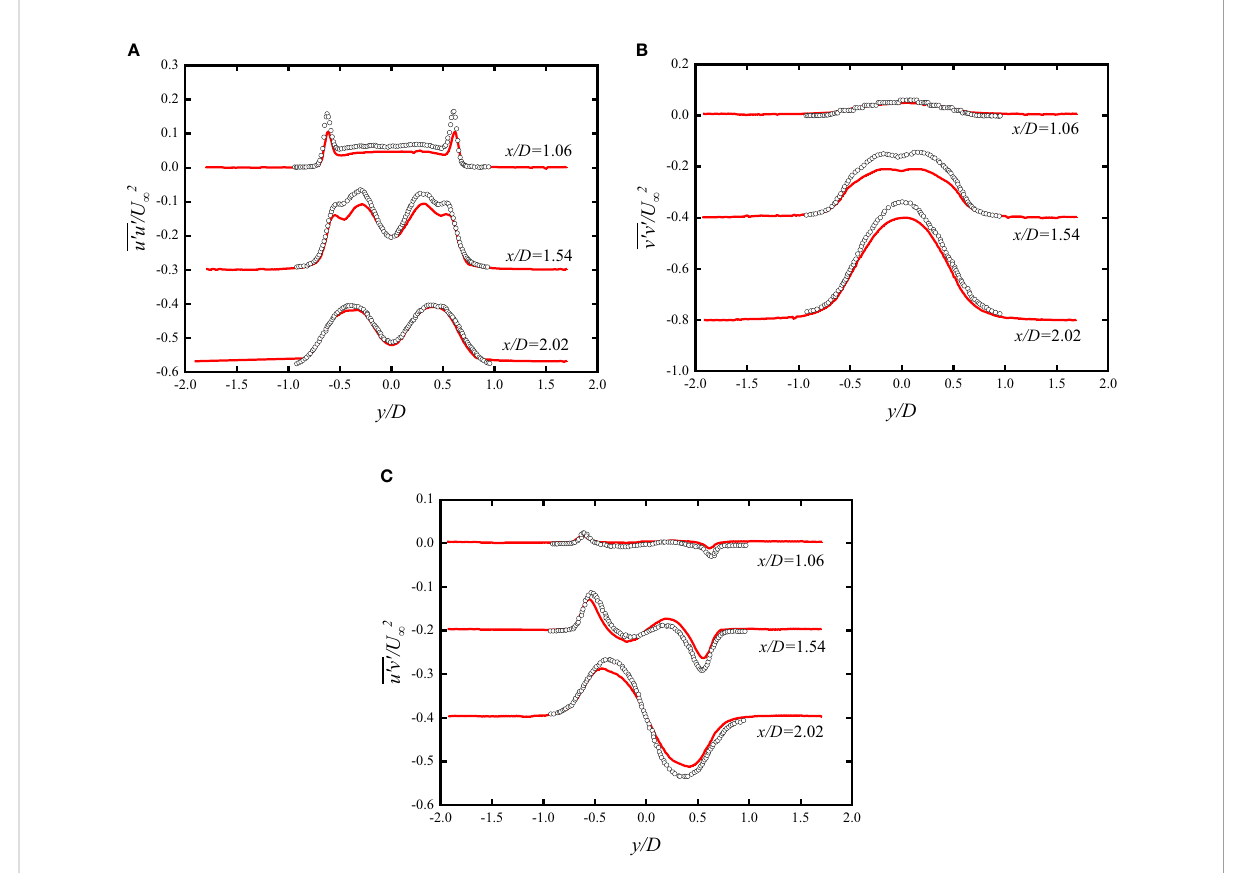
FIGURE 5 Normal and shear Reynolds stress component pro fi les for circular cylinders at Re=3900. (a) The variance of the streamwise velocity fl uctuations ¯(u'u')/U_ ∞ 2. (b) Variance of the transverse velocity fl uctuations ¯(v'v')/U_ ∞ 2. (c) Covariance of the velocity fl uctuations ¯(u'v')/U_ ∞ 2. The solid red curve represents the present URANS simulation; empty black circles are experimental data reproduced from (Parnaudeau et al.,